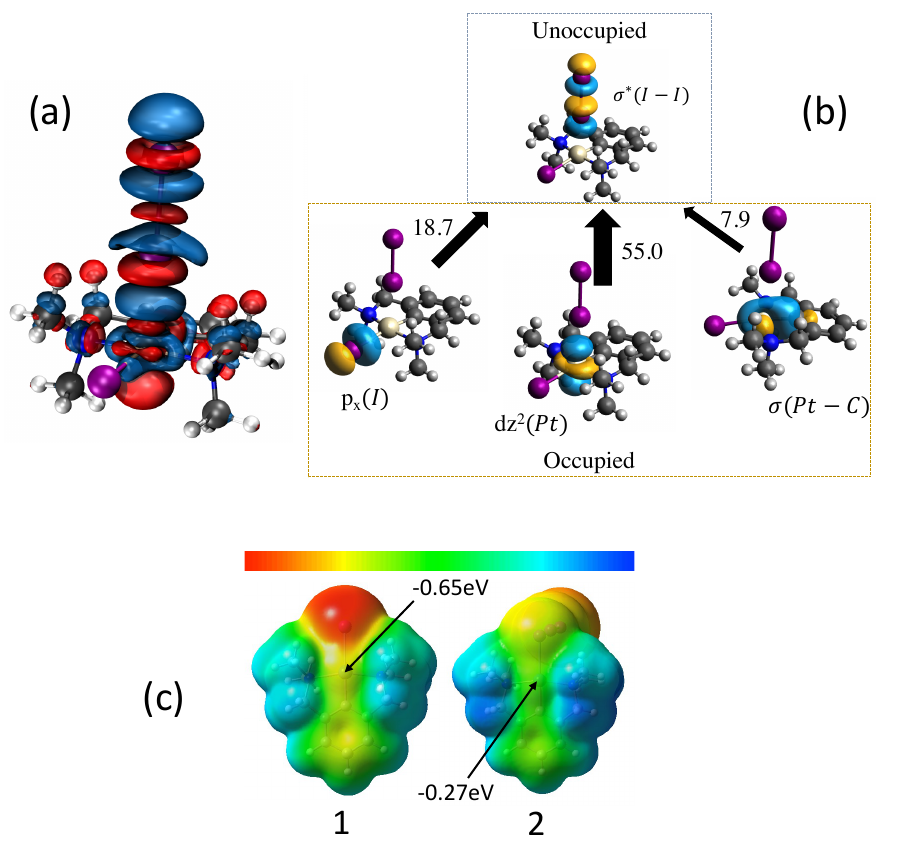
Figure 2. ( a ) Difference electron density distribution ∆ρ (r) for complex 1 . ∆ρ (r) is plotted for an electron density surface with a constant density value of 0.001 a.u. Blue regions indicate an increase in the electron density, red regions a density decrease relative to the superimposed density of the I and the Pt complex. ( b ) NBO charge transfer mechanism and CT delocalization energies given in kcal/mol. ( c ) Electrostatic potential mapped onto the van der Waals surface (0.001 a.u. isodensity) of the pincer of complexes 1 and 2 ; ranging from − 1.4 eV (red) to +1.4 eV (blue). PBE0–D3(BJ)/aug–cc– pVTZ/PP(M,I) level of